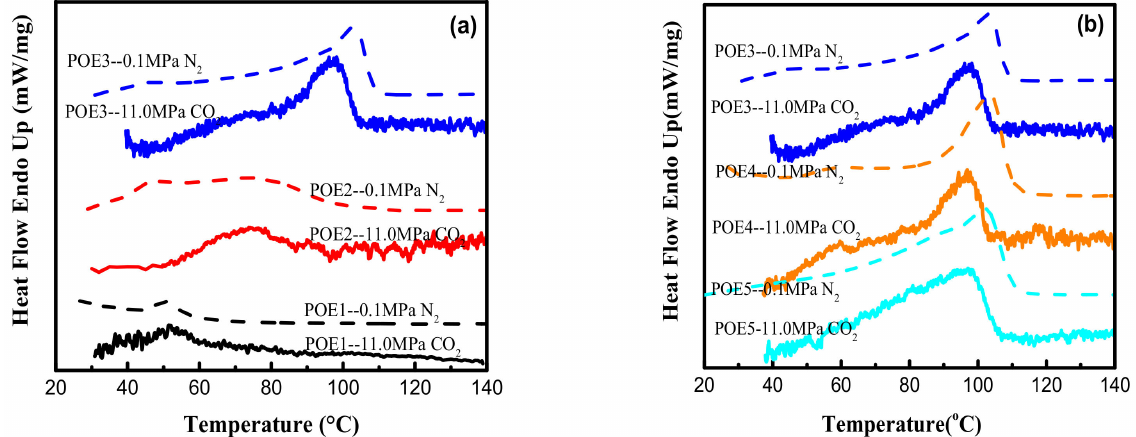
Figure 4. DSC curves of POE samples at a heating rate of 10 ◦ C/min. ( a ) POE samples with same MI; ( b ) POE samples with same octene